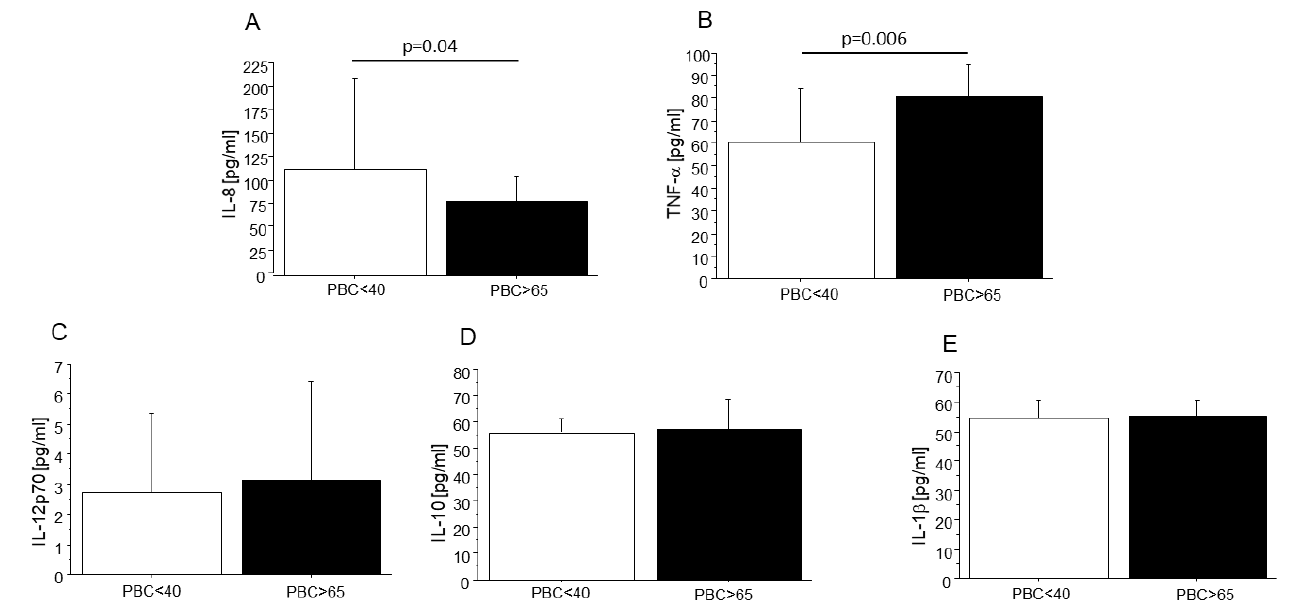
Figure 2. The levels of cytokines (IL-1 β , IL-8, IL-12p70, IL-10,and TNF- α ) in sera of PBC patients. Sera of PBC patients at an age of diagnosis under 40 ( n = 37) and over 65 ( n = 29) were incubated with the appropriate antibody conjugated with a fluorophore, and then flow cytometry analysis (cytometric bead assay (CBA)) ( A – E ) was performed. Levels of all cytokines are expressed in pg/mL. Results are presented as mean ± SD. Table 1. Significant correlation between cytokines and estrogens in sera of PBC patients at an age of diagnosis under 40 ( n = 37) and above 65 ( n = 29).